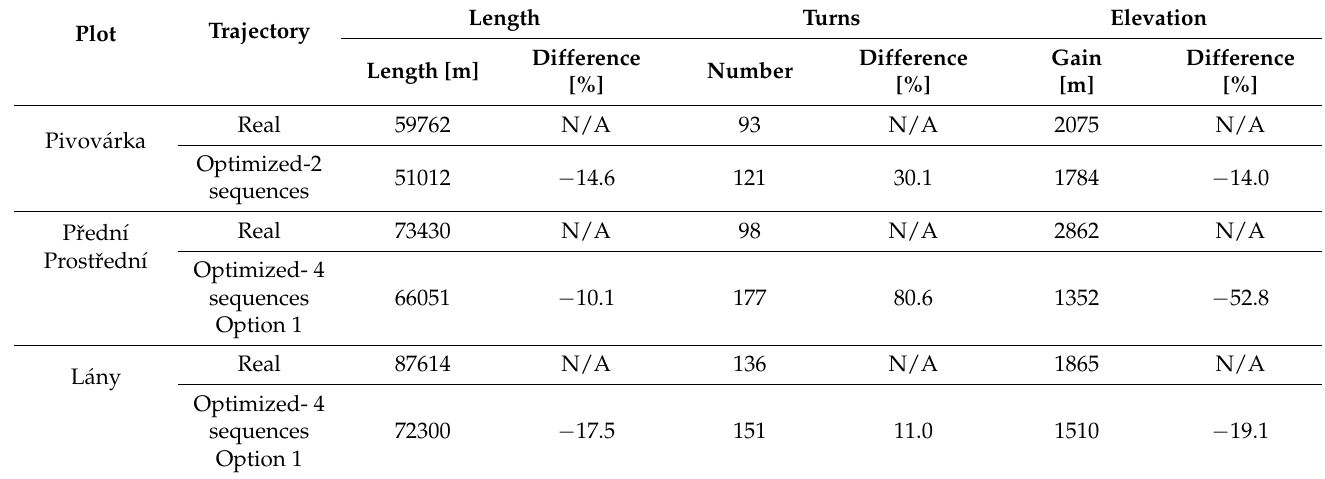
Table 2. Descriptive statistics: comparison of trajectory length, elevation gain, number of turns (headlands) for reference (real) trajectories and optimized (modeled) trajectories. Note, full statistical details are provided in Supplementary Materials.